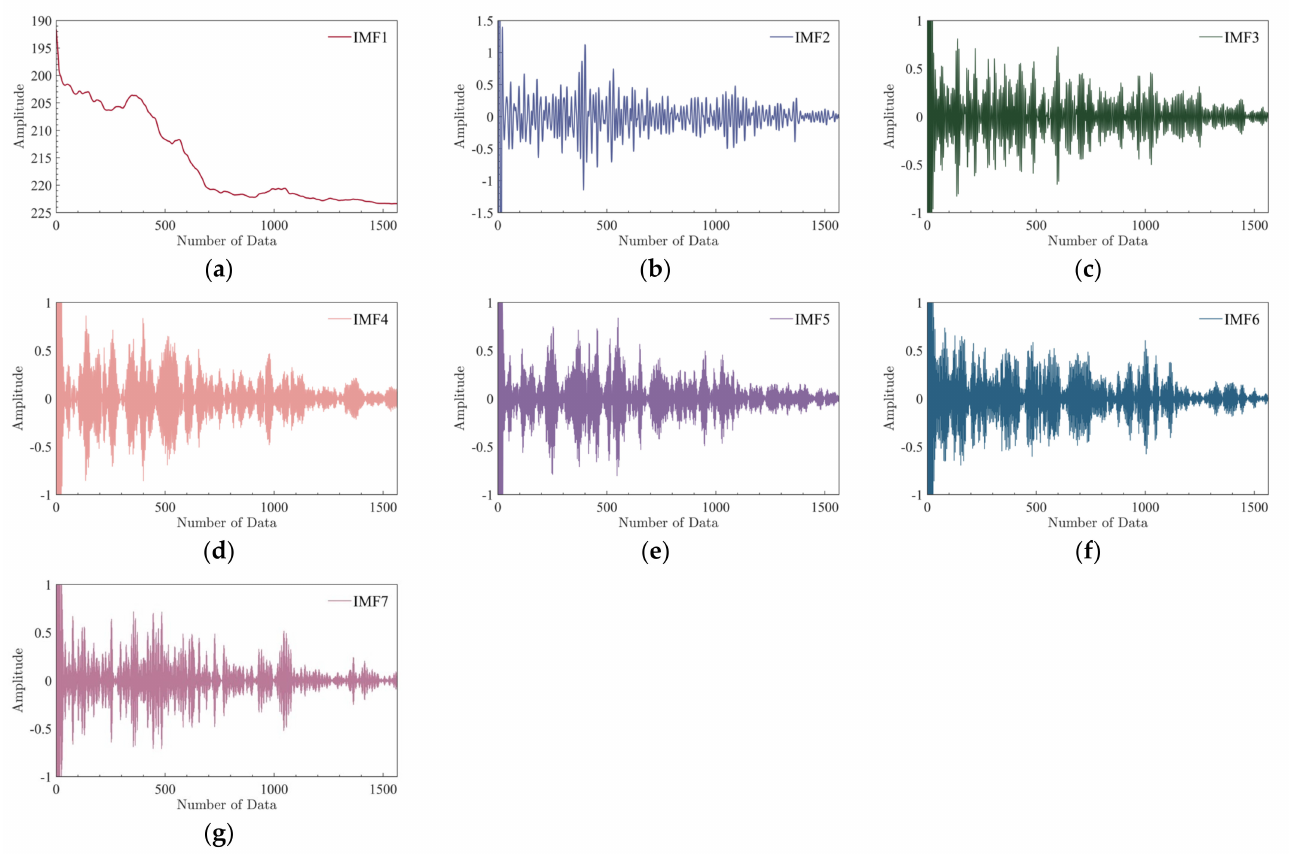
Figure 10. IMF components of PL sequence for the third set:( a ) IMF1; ( b ) IMF2; ( c ) IMF3; ( d ) IMF4; ( e ) IMF5; ( f ) IMF6; ( g )